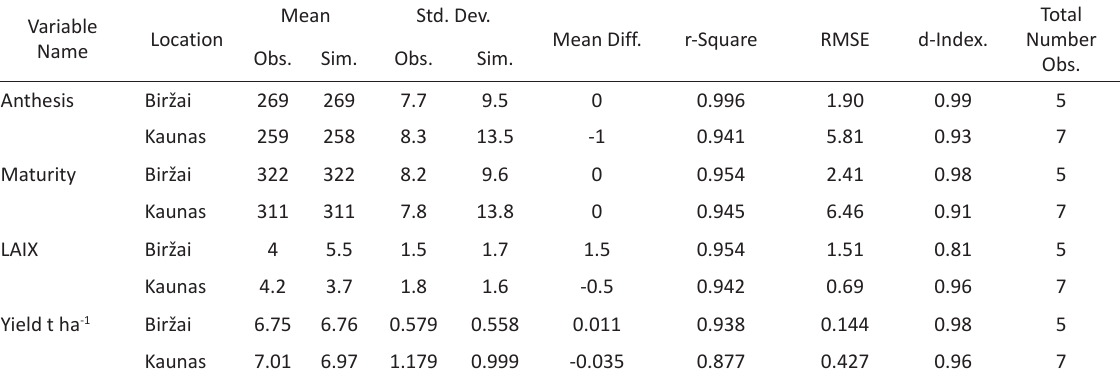
Table 5. DSSAT model calibration output with simulated and observed mean values, RMSE, d-index of major phenological variables (date of anthesis and physiological maturity (days)), yield (t ha -1 ) and maximum index of the leaf area (LAIX)